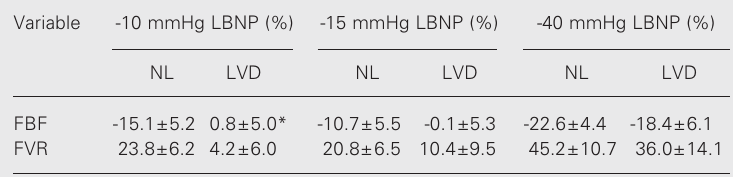
Table 3. Three-minute interval average measurements of variations in forearm vascu- lar resistance and forearm blood flow during lower body negative pressure.